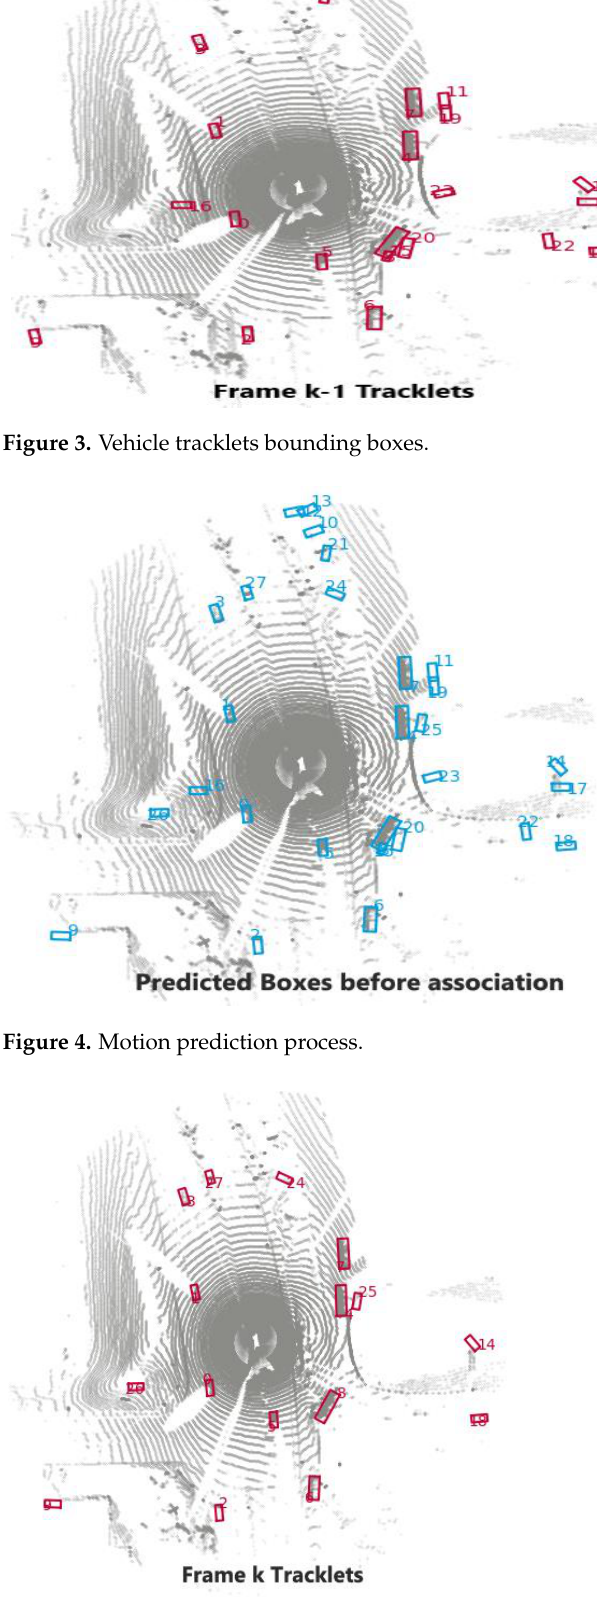
Figure 5. Tracklets at frame k.